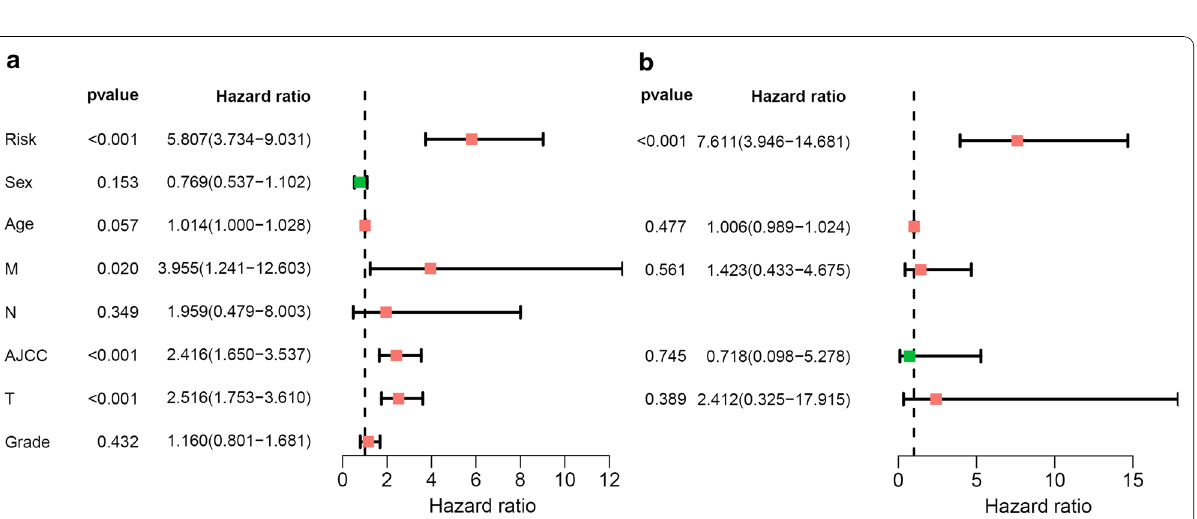
Fig. 8 Verification of the independence of the risk score by Cox regression analyses. a Univariate Cox regression analyses incorporating the corresponding clinical information with the risk score. b Multivariate Cox regression analyses based on the clinical data and risk